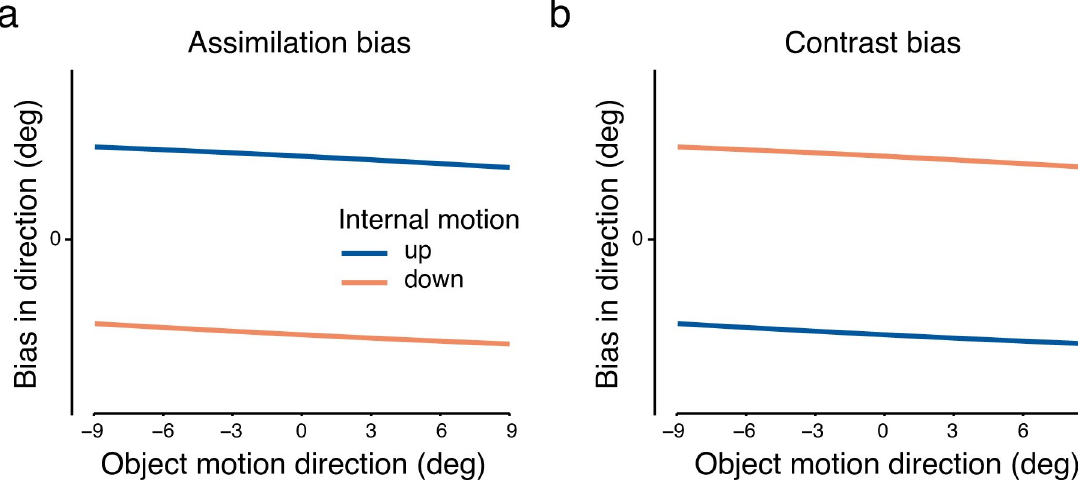
Fig 3. Alternative hypotheses for (a) assimilation bias and (b) contrast bias. The plots show the pattern of averaging/contrasting object and internal motion directions.